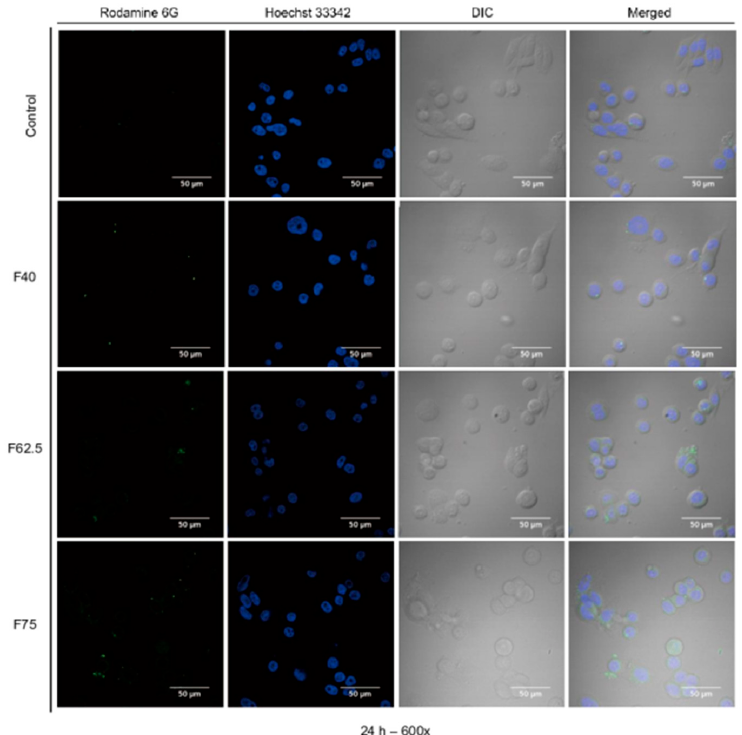
Figure 8. The confocal images of Rho-sBSANP uptake by MDA-MB-468 cells after 24 h treatment. Magnification 600×. Note: Rhodamine 6G channels showing the green fluorescence from Rho-sBSANP distributed; Hoechst 33258 channels showing the blue fluorescence from Hoechst 33258-stained nuclei; DIC channels showing the di ff erential interference contrast; merged channels of channels where liposomes (green) localized at nuclei of MDA-MB-468 cells (blue). Magnification: 600 ×